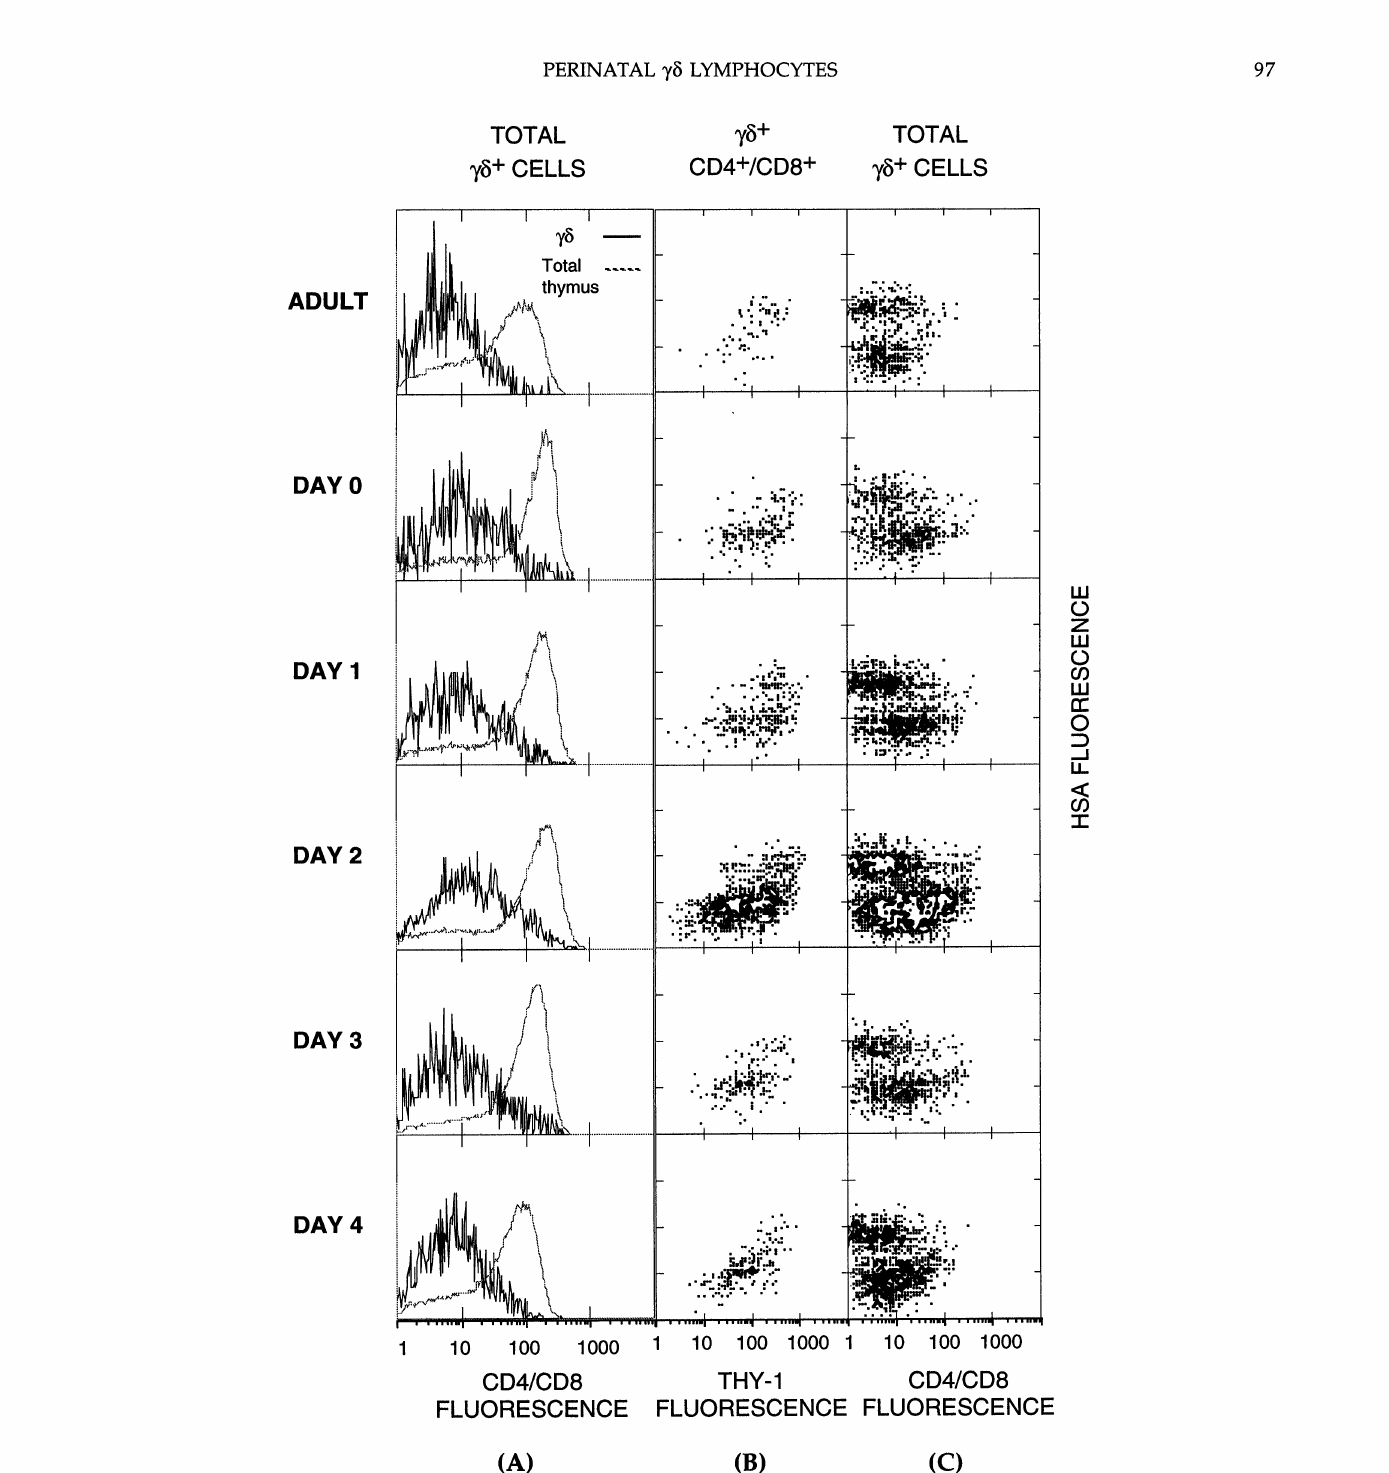
FIGURE 3. The Thy-1 and HSA expression of the 73 thymocytes that bear CD4 or CD8. The analysis was performed on cells isolated from the thymuses of 6 to 20 mice at ages 0 to 4 days and adult. The data shown are representative of three experiments. (A) The histograms show the CD4/8 fluorescence of total 7 T cells (solid line) for the first 5 days following birth and in the adult thymus. The CD4/8 profile of total thymus at each time point is included to indicate the level of positive staining (dotted line). (B) The HSA and Thy-1 profiles of the 7 T thymocytes that have a CD4/8 fluorescence above an arbitrary level of fluorescence 25 on the log scale. (C) Contour plots of gated 7 TCR cells. The CD4/8 fluorescence is plotted against the HSA fluorescence to demonstrate that the majority of CD4/8 cells have an HSA- phenotye as indicated in